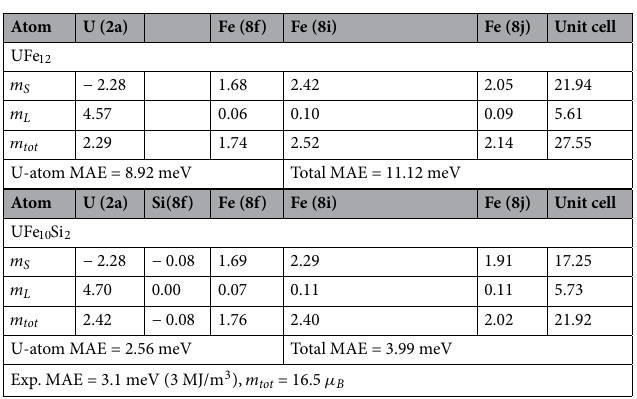
Table 2. The spin m S and orbital m L magnetic moments (in µ B ) for U and Fe atoms in different Wyckoff positions, aligned along [001] crystal direction. The total magnetic moment in the unit cell m tot , and the magnetic anisotropy energy MAE (in meV) in comparison with experimental data.